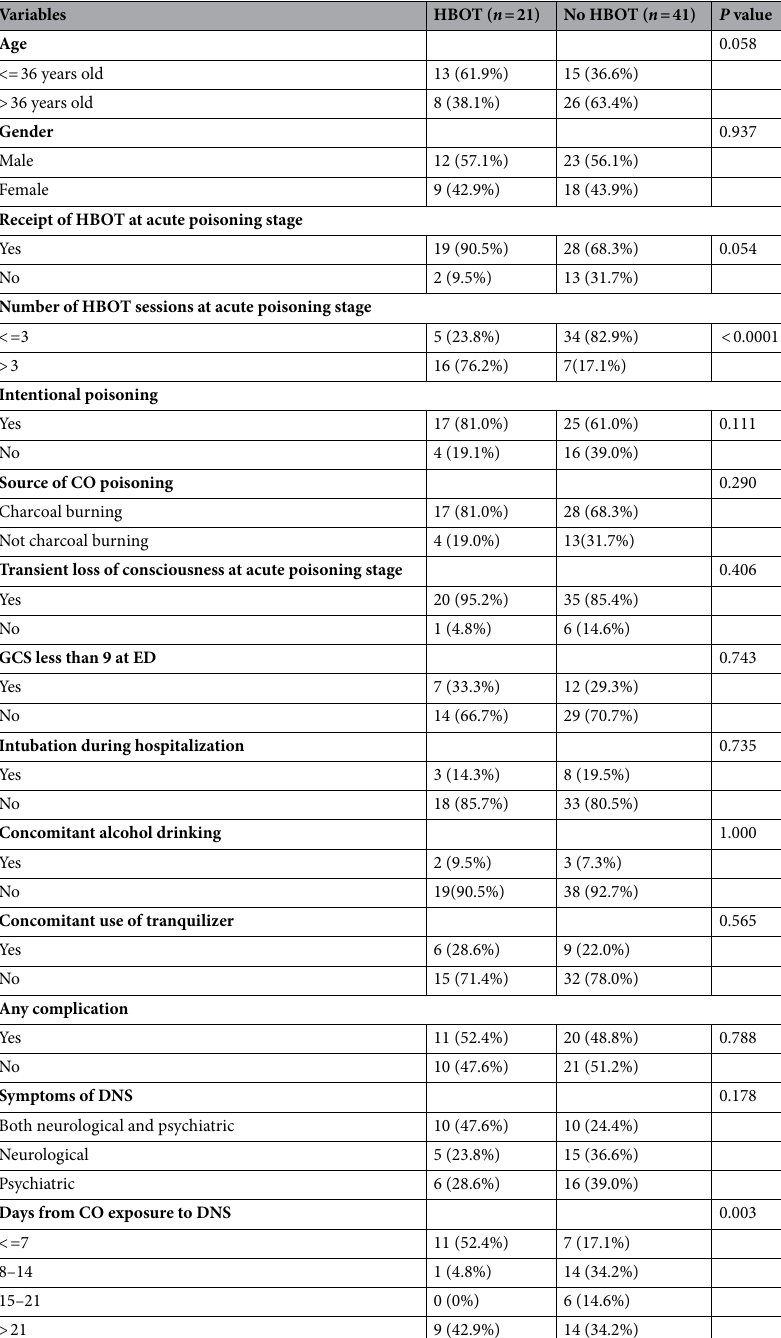
Table 1. Demographic and clinical data of patients with and without HBOT after DNS development. Continuous data are expressed as mean ± standard deviation; categorical data are presented as frequency (proportion). HBOT hyperbaric oxygen therapy, DNS delayed neuropsychiatric sequelae, GCS Glasgow Coma Scale, ED emergency